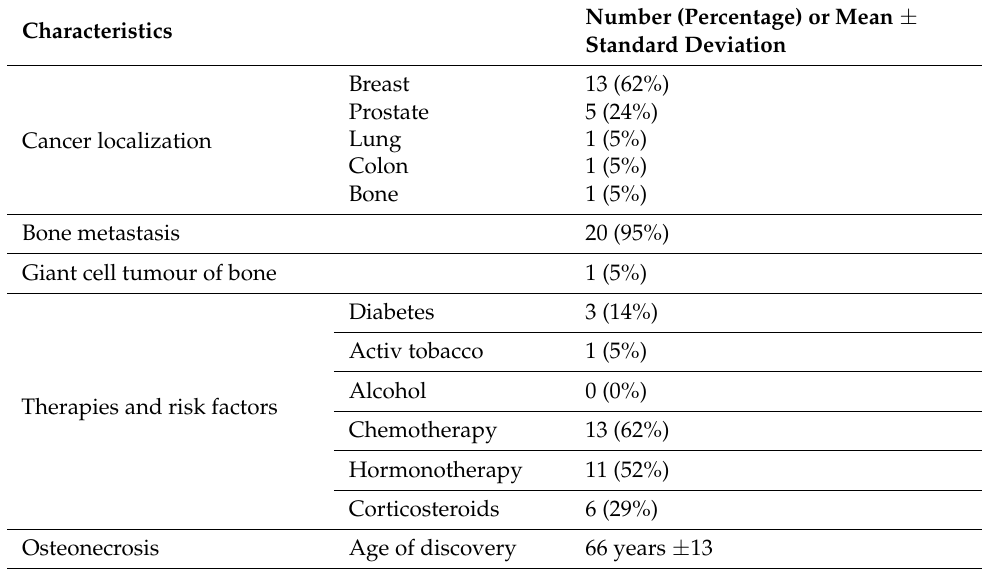
Table 2. Clinical characteristics of 21 patients with MRONJ and available CBCT.